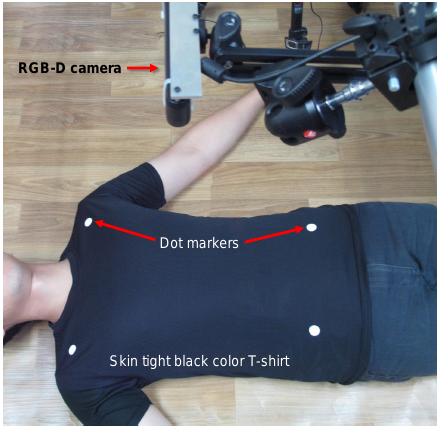
Figure 2. Experimental setup where the patient is laying down in the supine position wearing a skin-tight t-shirt with four white color dot markers. The RGB-D camera is placed nearly 85 cm above the